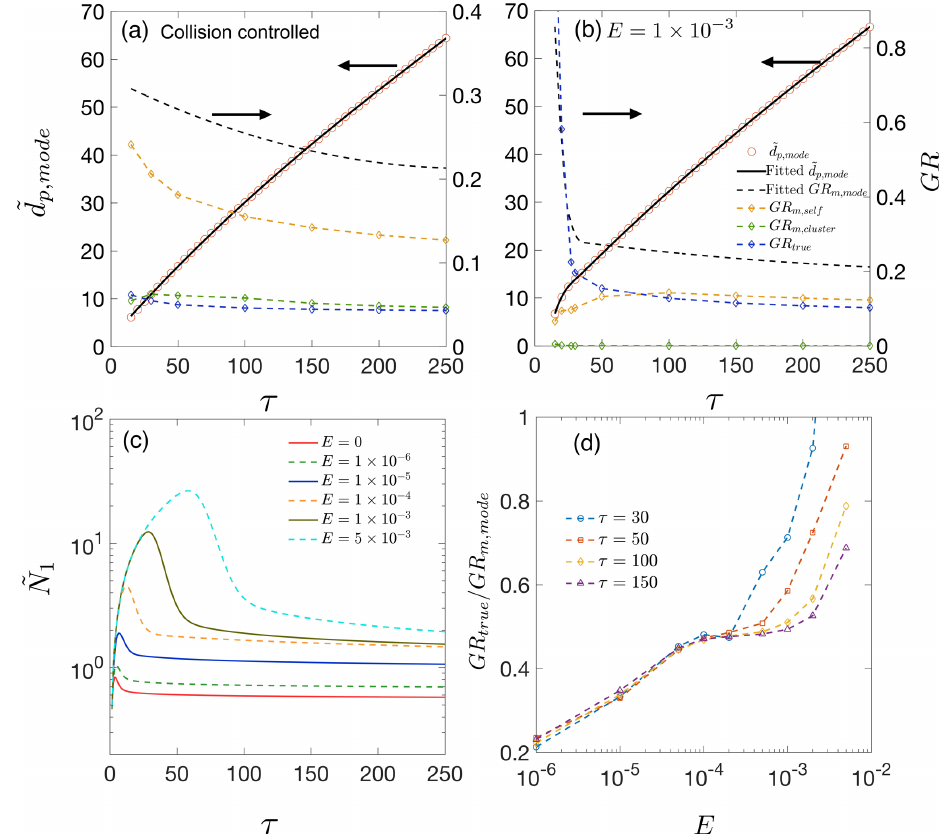
Figure 2. (a) e d p , mode and various growth rates as functions of time for collision-controlled nucleation. Dashed black lines show the value of GR m , mode . Yellow, green and blue dashed lines represent GR m , self , GR m , cluster and GR true , respectively. (b) The same quantities as are shown in panel (a) but with the evaporation constant set to E = 1 × 10 − 3 . For both panels (a) and (b) , the left axis shows values for the solid lines and the right axis shows values for the dashed lines. (c) Monomer concentration as functions of time for different values of E . (d) GR true / GR m , mode for different values of E at τ = 30, 50, 100 and